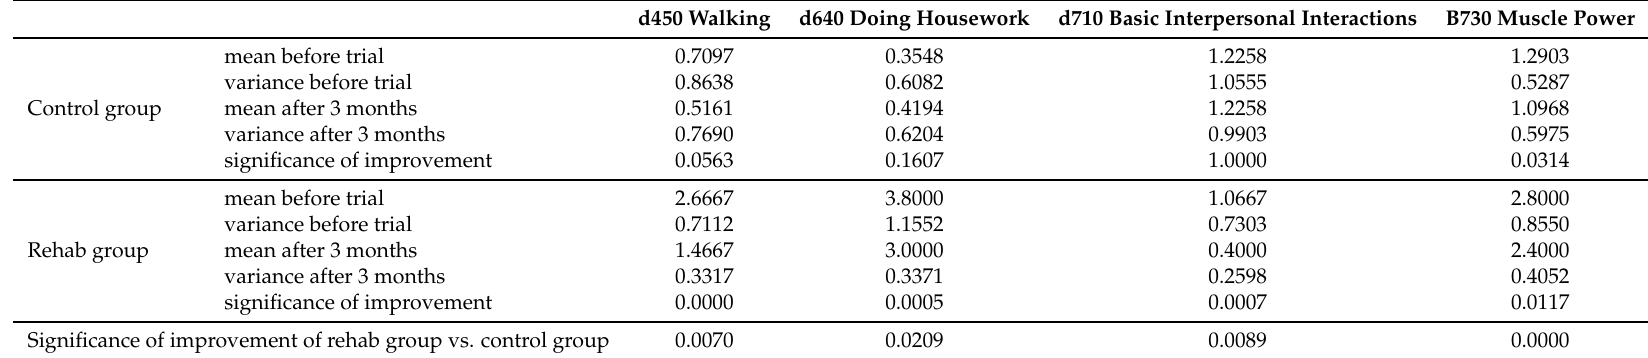
Table 2. Comparison of 3-month rehab results between control group and rehab group under International Classification of Functioning, Disability and Health (ICF) subjective evaluation system.